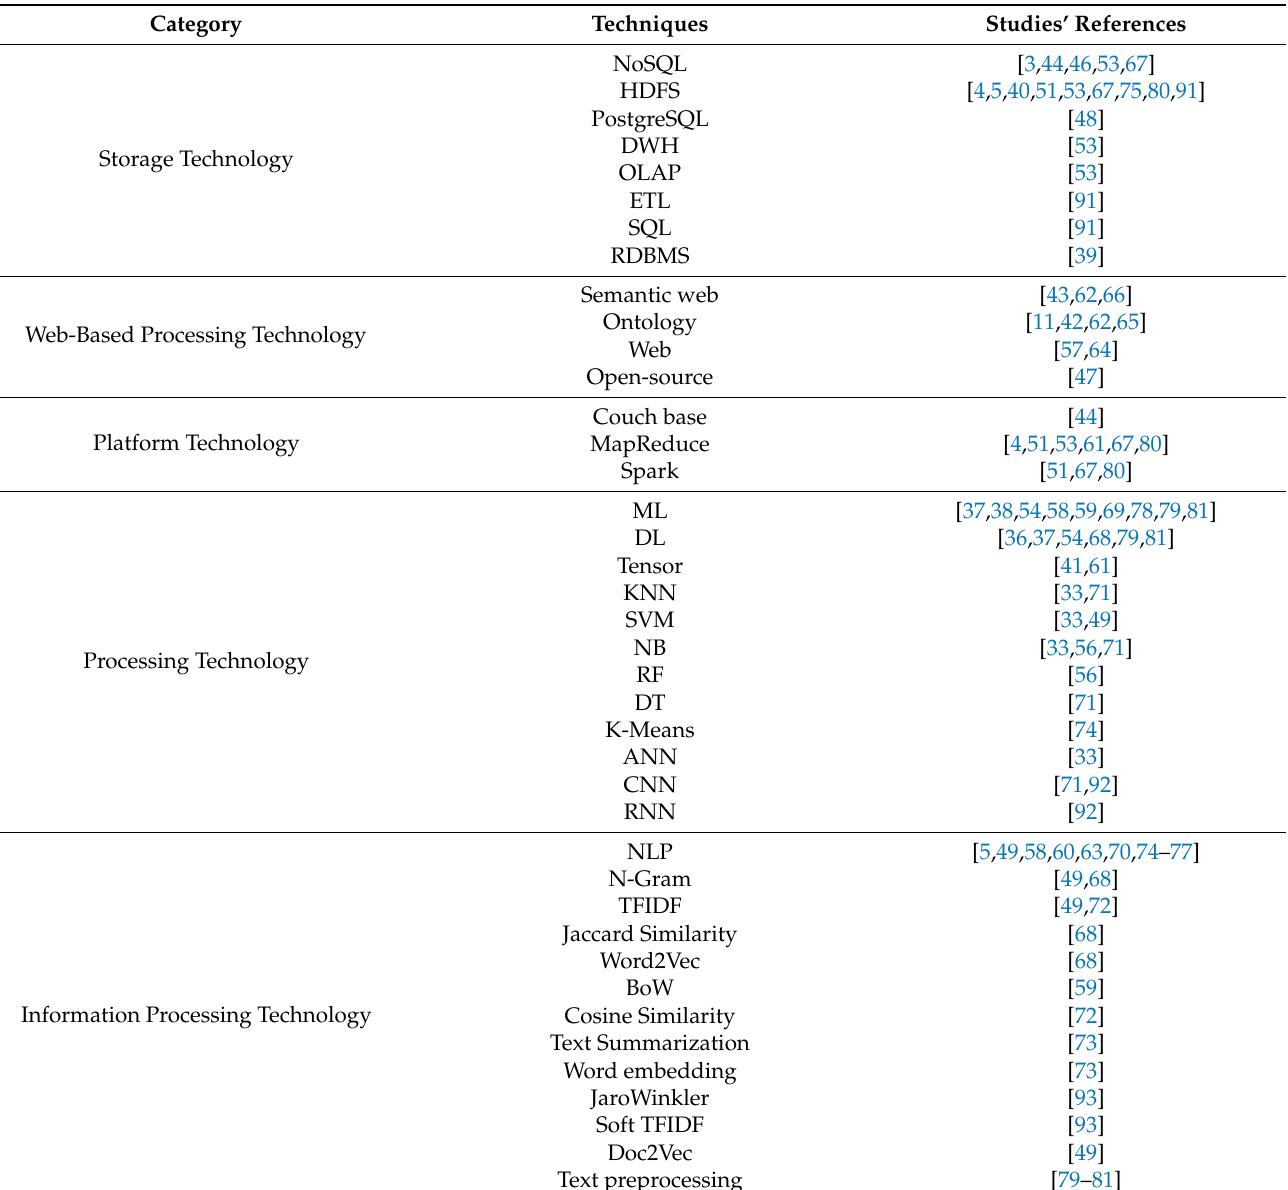
Table 10. Common